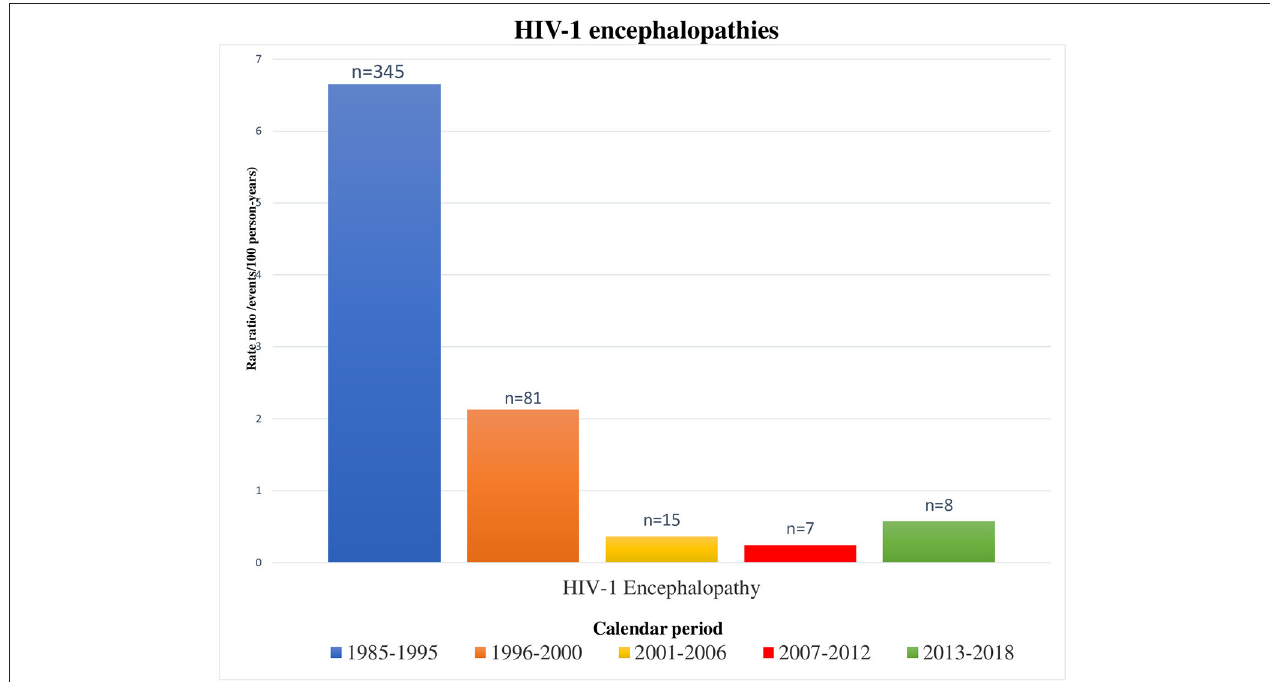
FIGURE 5 | Encephalopathies/neurocognitive delay occurred in HIV-1 infected children by calendar period, from 1985 to 2018 [1985–1995 and 1996–2000 periods refer to our previous results